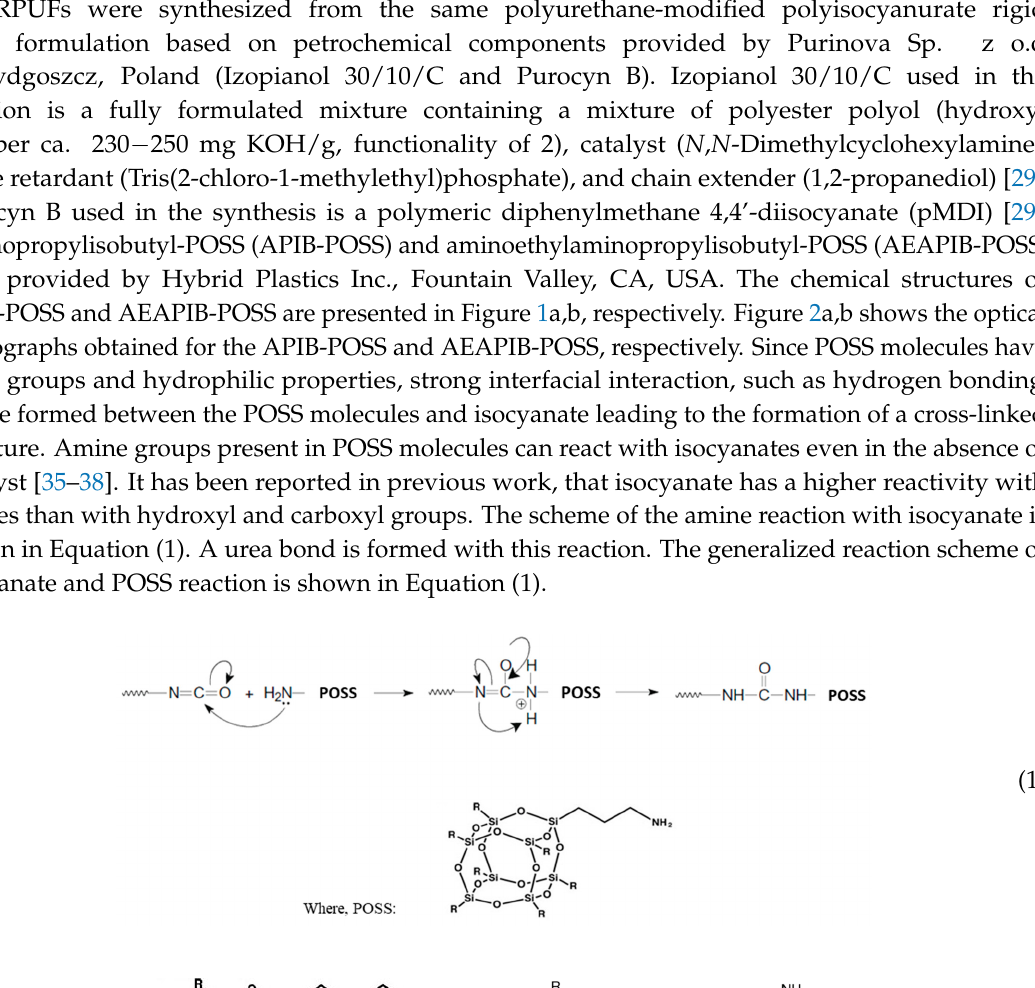
Figure 1. Chemical structure of ( a ) APIB-POSS and ( b ) AEAPIB-POSS.